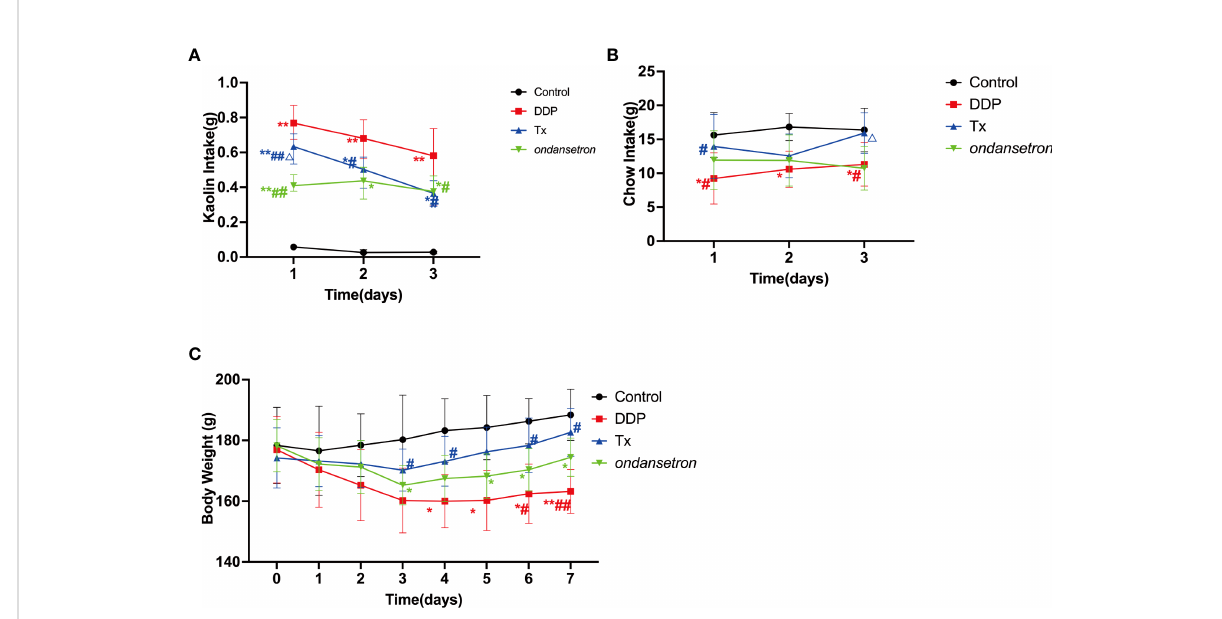
FIGURE 1 Anti-CINV Ef fi cacy of LJAW in a Cisplatin-induced Rat-Pica Model. (A) Kaolin intake of rats during the fi rst 3 days after chemotherapy (n = 10 biologically independent animals per group, data are presented as mean ± sem, normality was tested by Shapiro-Wilk normality test, p values were determined by using one-way ANOVA). (B) Food intake of rats during the fi rst 3 days after chemotherapy (n = 10 biologically independent animals per group, data are presented as mean ± sem, normality was tested by Shapiro-Wilk normality test, p values were determined by using one-way ANOVA). (C) Dynamic changes in body weight of rats during the whole experiment (n = 10 biologically independent animals per group, data are presented as mean ± sem, normality was tested by Shapiro-Wilk normality test, p values were determined by using one-way ANOVA). (*, p < 0.05 compared with control; **, p < 0.01 compared with control. #, p < 0.05 compared with cisplatin (DDP); △ , p < 0.05 compared with ondansetron